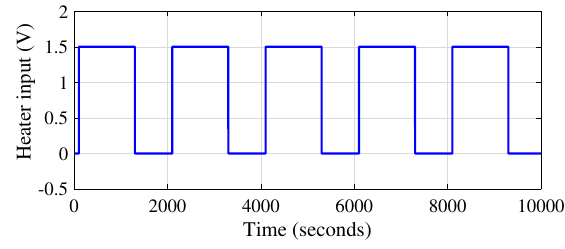
Figure 6: Input profile for parameter estimation The considered input signal for parameter estima- tion is a pulse function shown in Fig. 6. This signal is informative enough to capture the dynamics of the heating chamber and obtain the estimates. The amplitude of signal is selected to 1 . 5 V to change the temperature of chamber up to around 30 ◦ C . The period of the signal is 2000 sec , with the pulse width of 60%, which is long enough for the plant to reach at least 80% of its final